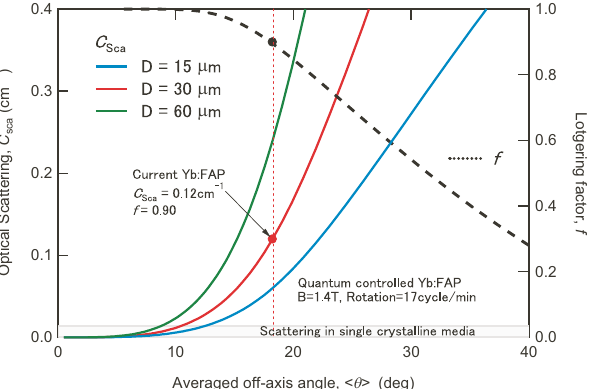
Figure 3. The relationships between < θ > , f and C sca in Yb:FAP with quantum-controlled microdomains. < θ > , f , and C sca are the theoretical mean deflection angle between the c -axis and controlling direction, the Lotgering factor, and the optical scattering coefficient. Dotted and solid lines show the relations between < θ > and f , and between < θ > and C sca ,